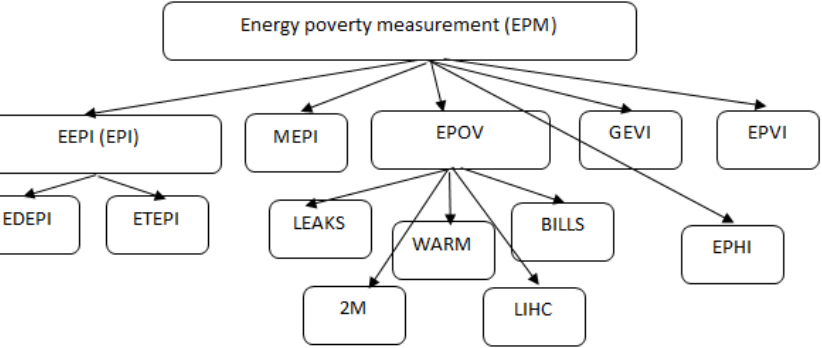
Figure 4. Energy poverty measurement system—framework and selected elements. Source: own